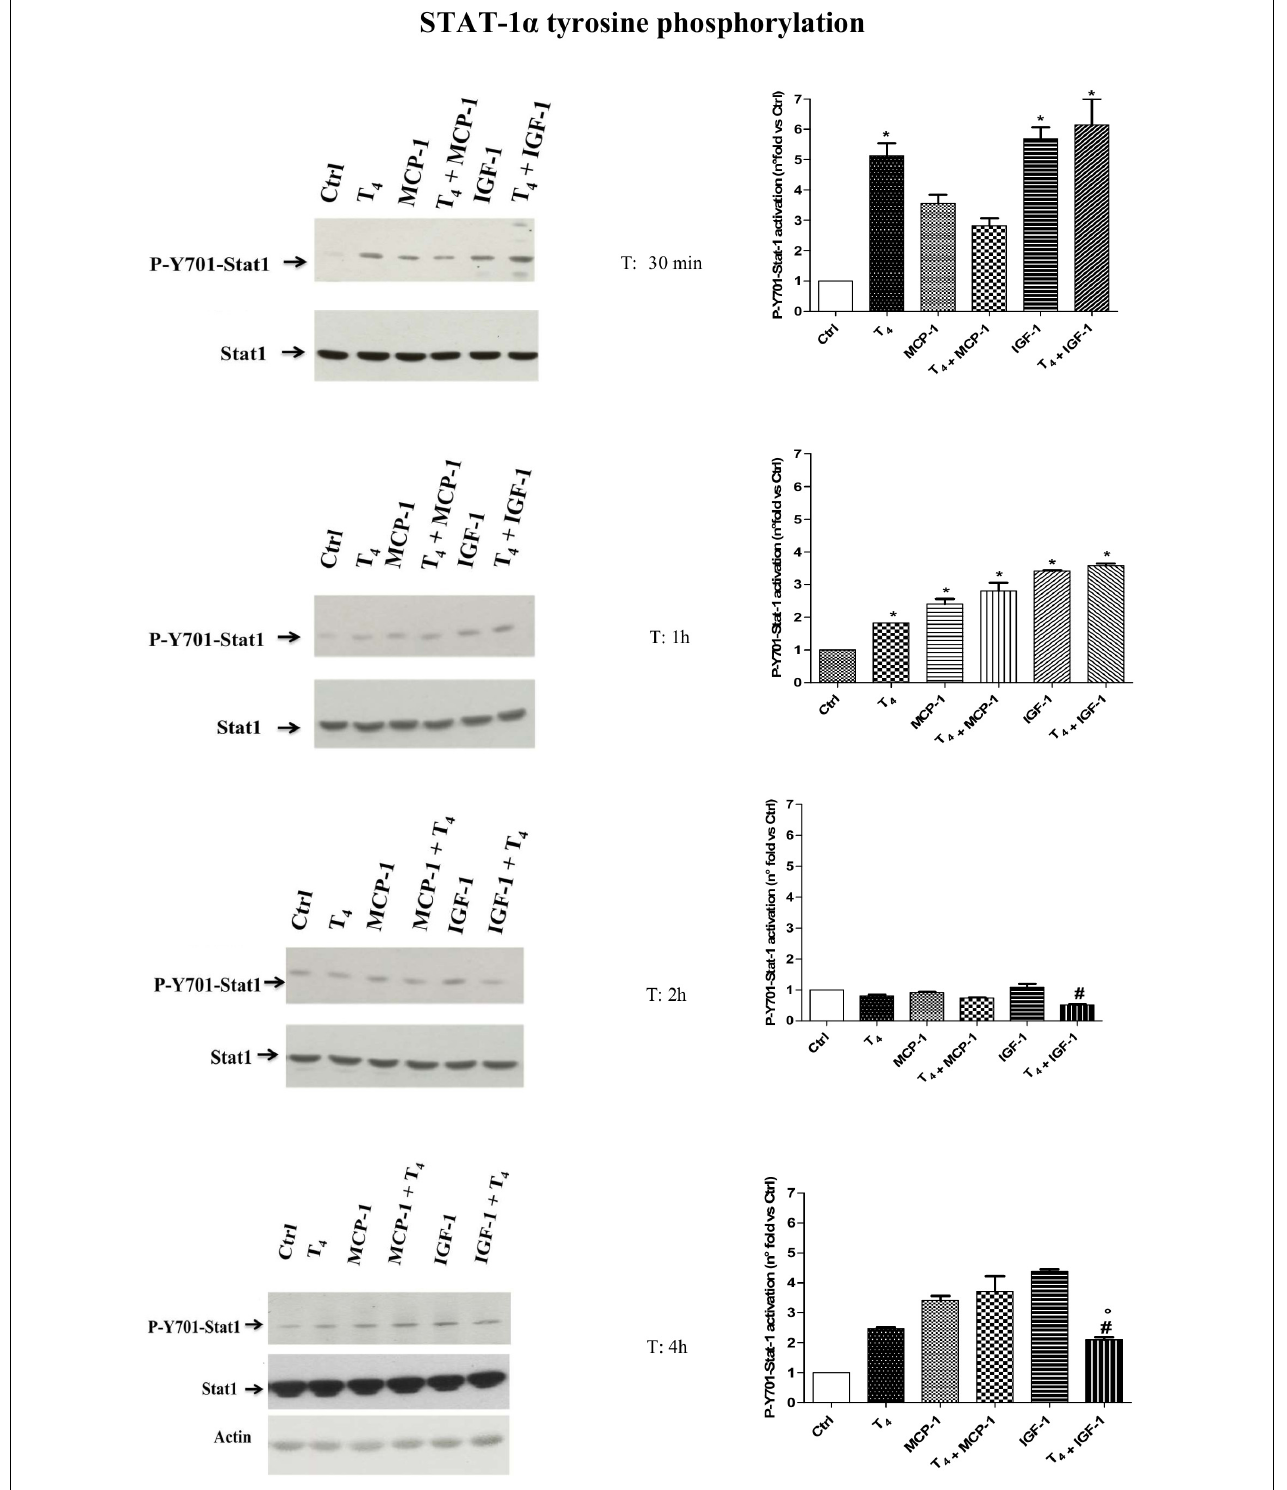
FIGURE 9 | Western blot and densitometric analysis of P-Y701-Stat1 activation after 30 min, 1 h, 2 h, and 4 h of T 4 (10 − 7 M), monocyte chemoattractant protein 1 (MCP-1; 100 ng/ml), and insulin-like growth factor-1 (IGF-1; 10 − 8 M) stimulation of THP-1 cells. Western blot of one of two independent experiments was reported. The densitometric analysis is reported as mean ± SD of n = 2 different experiments. * p < 0.01 vs. Ctrl; # p < 0.05, at least, vs. IGF-1; ◦ p < 0.05 vs. T 4 + MCP-1.